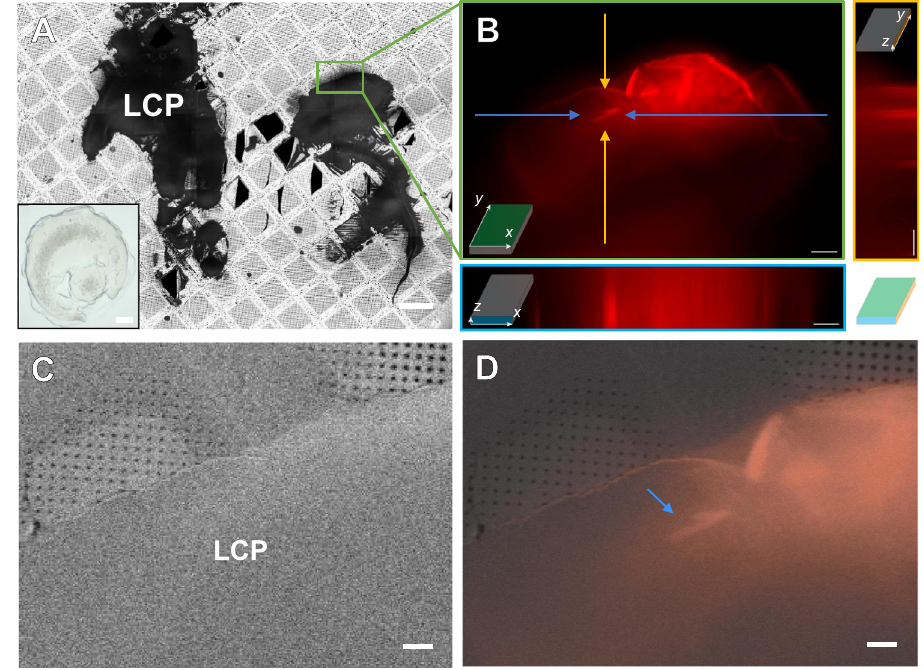
Fig.1|Identi fi cationandtargetingof fl uorescentlylabeledGPCRmicrocrystals in thick LCP. A 500V SEM image montage of a prepared grid of the human A 2A adenosinereceptor(A 2A AR)inlipidiccubicphase(LCP).InsetshowsatypicalA 2A AR drop.Scalebar100 µ m. B FluorescentimagefromaZ-stacktakenfromthelocation highlighted from A in the green box. The bottom and right panels depict the